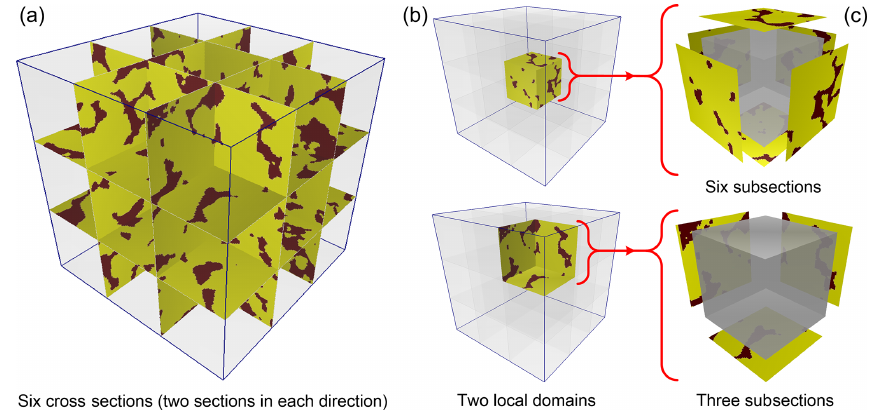
Figure 1. Local subsections divided by their spatial relationships and the corresponding training images. (a) Six cross sections in a 3-D domain: two sections along each direction; (b) two local domains: a central cube and a corner cube; (c) corresponding subsections (training